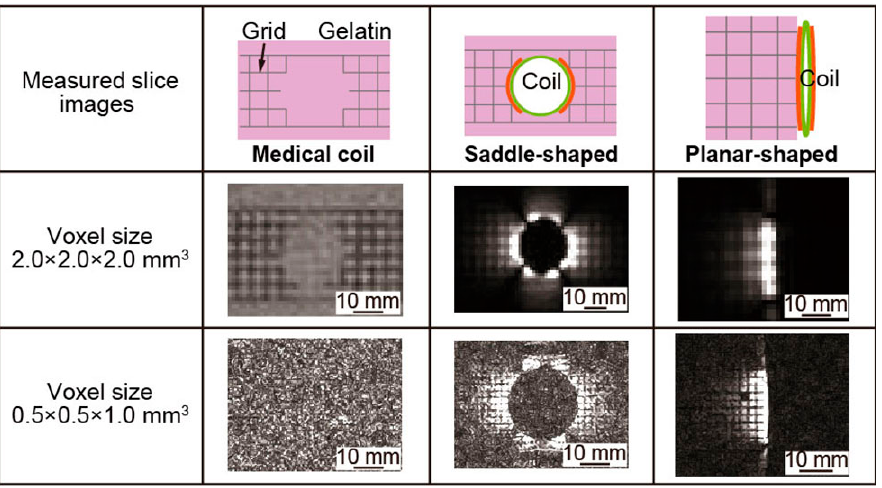
Figure 9. The MRI images taken by medical head coil, saddle-shaped, and planar-shaped mode coil with the voxel size of 0.5 × 0.5 × 1.0 mm 3 and 2.0 × 2.0 × 2.0 mm 3 .